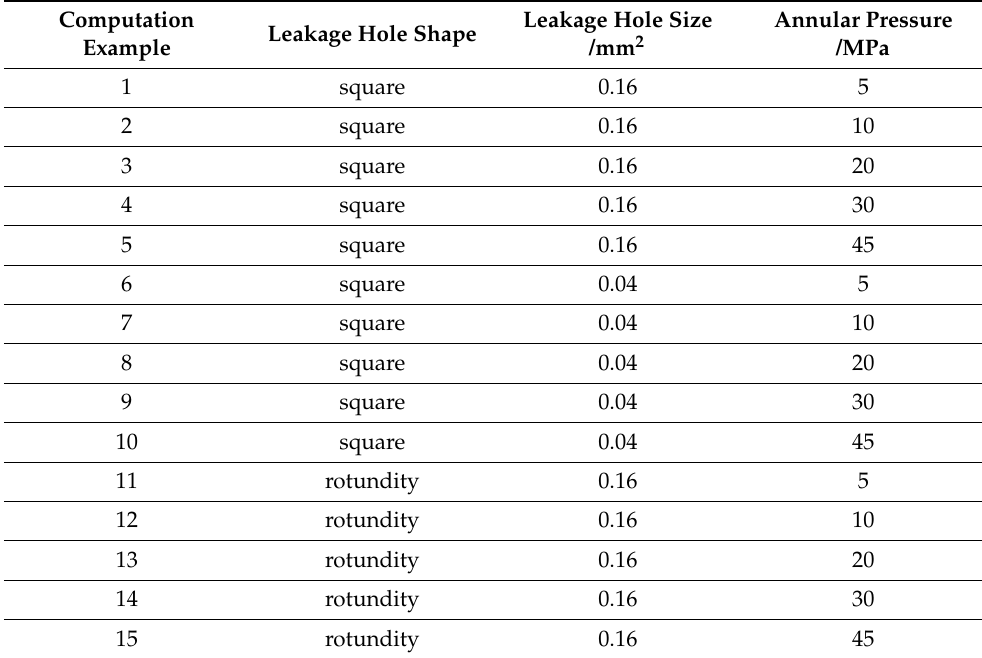
Table 2. Computation of working conditions for flow field sensitivity